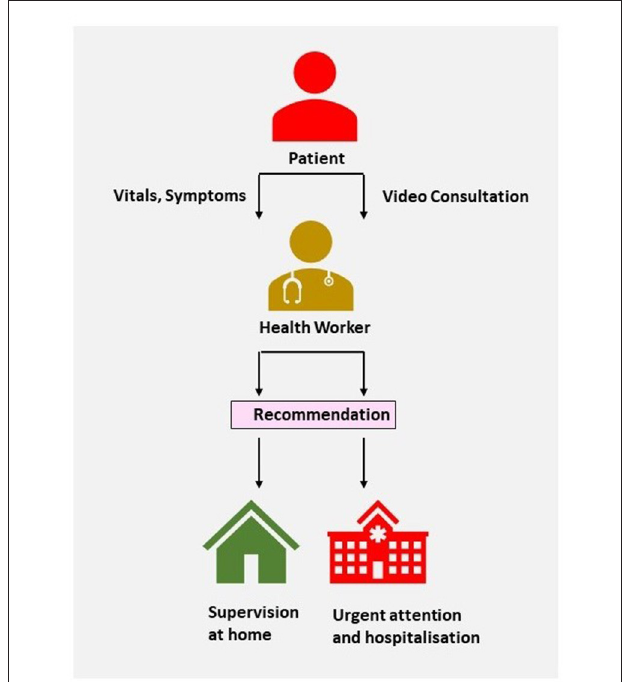
FIGURE 1 | A typical patient monitoring